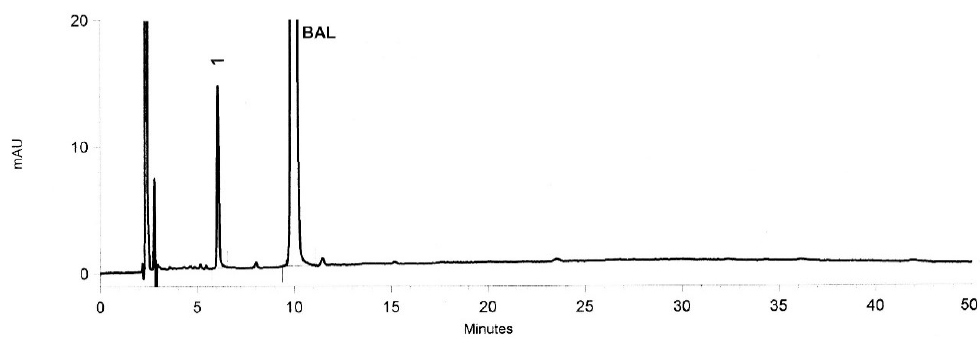
Figure 7. Chromatogram of LOM after oxidation by H 2 O 2 after incubation for 168 h.